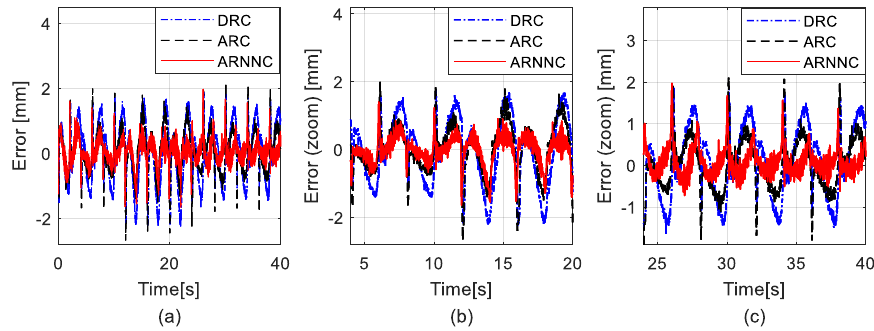
Figure 11. Tracking performances of 90Sin ( 0.5 π t − 0.5 π ) with sinusoidal disturbance ( a ) Tracking errors of different controllers. ( b ) Zoomed tracking errors from 4 to 20 s. ( c ) Zoomed tracking errors from 24 to 40 s.